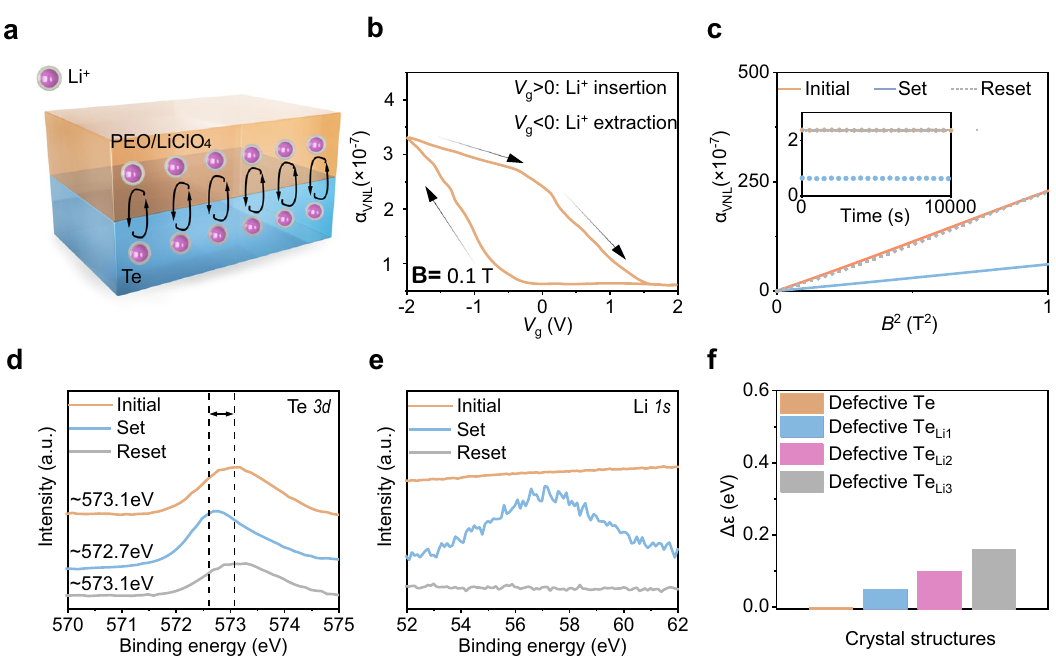
Fig. 4 | Non-volatile valley transistors based on reversible ion insertion/ extraction at room temperature. a Schematic of non-volatile valley transistors withthesolid-electrolytePEO/LiClO 4 .TheblackarrowindicatesthemovementofLi ions. b Transfer curves with hysteresis under B // E and B =0.1T. The black arrow indicates the sweeping direction of V g . c Output curves of different states. Inset shows the non-volatile valley states under the retention tests of 10,000s. Set cor- respondstothegatingof+2Vwith1s,whileresetisthegatingof − 2Vwith1s. d XPS 3d spectraofTe.Theverticaldashedlinesandthearrowindicatetheshiftofpeaks.